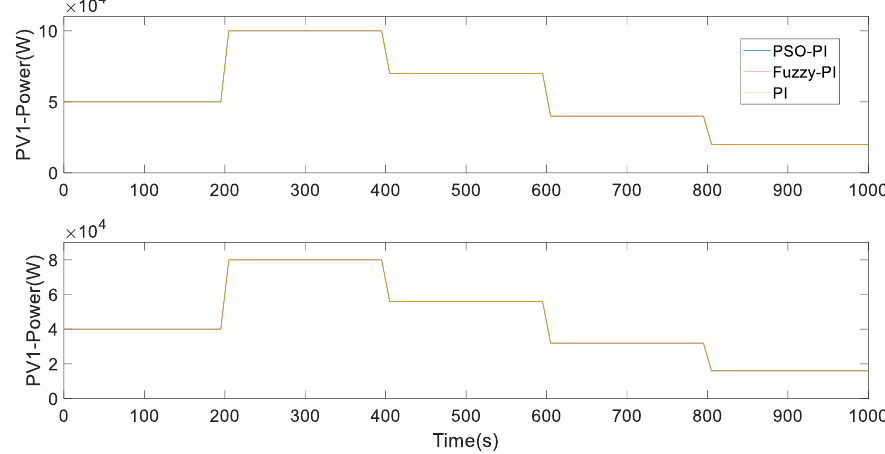
Figure 15. Output power of photovoltaic unit in Example 1.